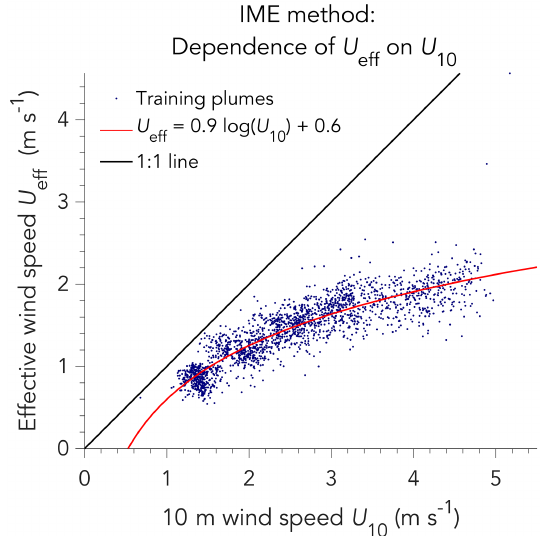
Figure 4. Relationship between the effective and local 10m wind speeds in the IME method, characterized with LES training plumes assuming 1% instrument precision. Each point represents a differ- ent LES plume pseudo-observation from the training set. The red line fits the data to a logarithmic dependence. The 1 : 1 line is shown in black. See text for similar results with 3% or 5% instrument pre-